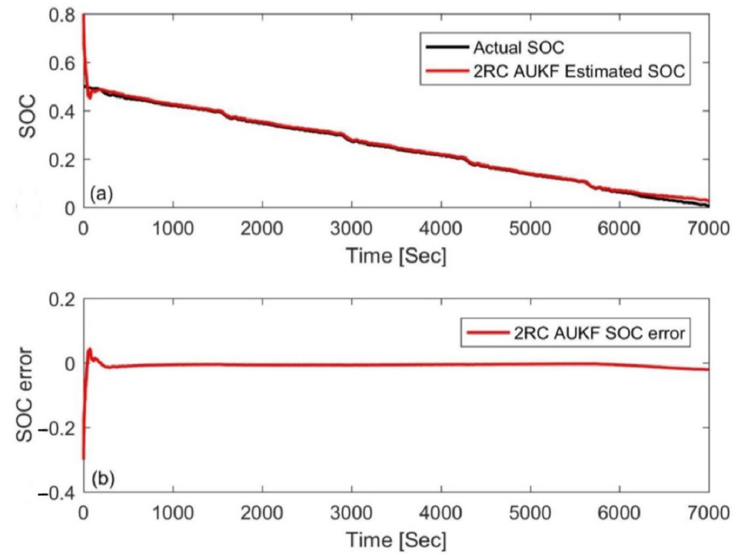
Figure 8. Estimation results by the AUKF at an initial SOC value of 80%. ( a ) SOC estimation comparison curve; ( b ) SOC estimation error.